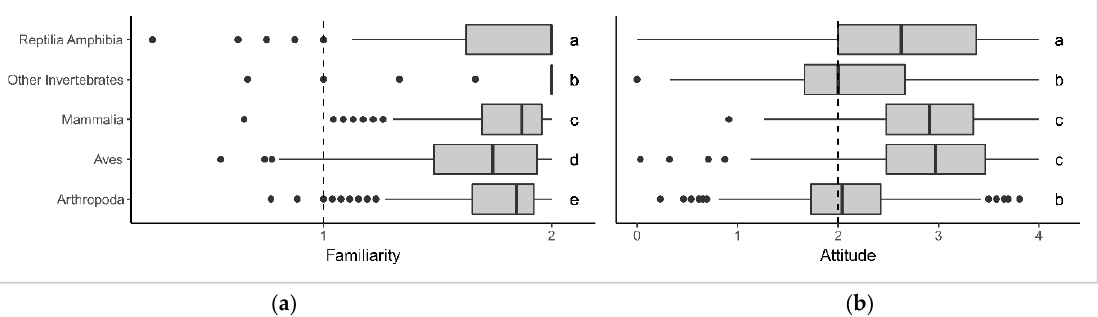
Figure A3. Familiarity (( a ); F 4, 2370 = 92.97, p < 0.001) and attitude (( b ); F 4, 2370 = 163, p < 0.001) at the taxon level. Taxa are alphabetically ordered. Equivalent letters behind the graph indicate groups that do not significantly differ from each other. N = 475.